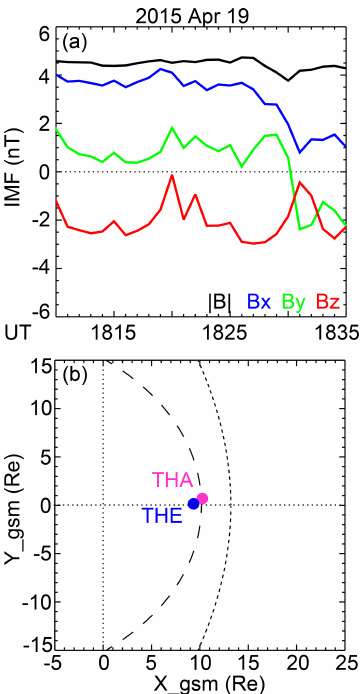
Figure 4. OMNI IMF condition and THEMIS satellite locations on 19 April 2015 in a similar format to Fig.